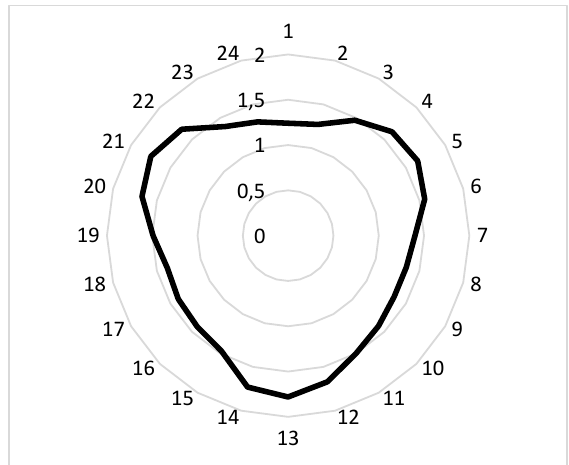
Fig. 5 . The thickness  in mm of the workpiece at a radius of 32